Question: What form of chart is displayed?
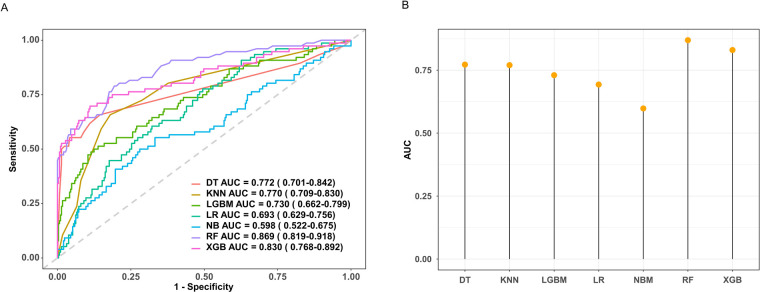
Answer: line